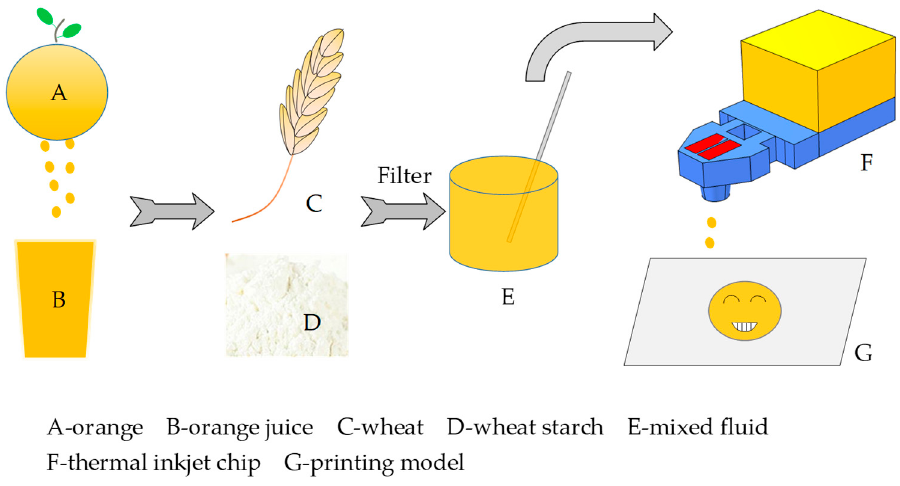
Figure 1. Orange juice and wheat starch were used in inkjet printing.